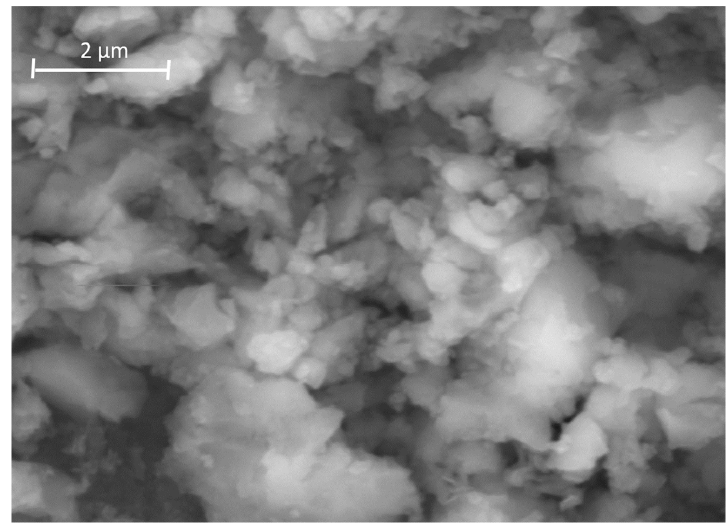
Figure 12. SEM images of Ca, P-rich agglomerates on the Mg-1.5Ga-6Zn alloy after 168 h of immersion in SBF.